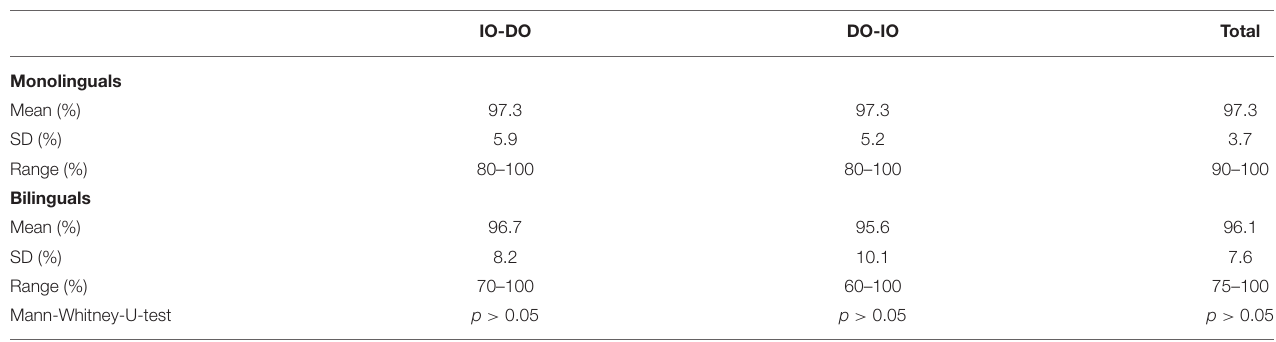
TABLE 5 | Monolinguals’ and bilinguals’ accuracy in the sentence–picture matching task. IO-DO DO-IO